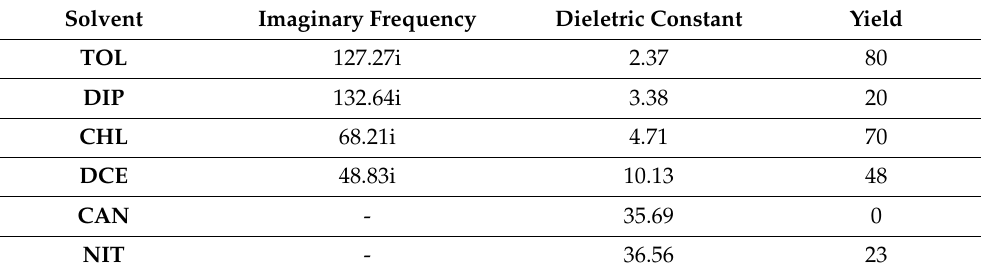
Table 1. Imaginary frequencies (cm − 1 ), dielectric constant (in Debye) and yield (%) of the reactions associated with the transition states as a function of the